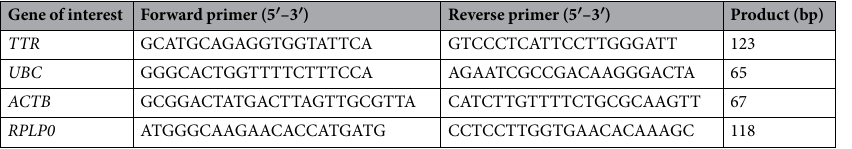
Table 2. Sequences of primers used for